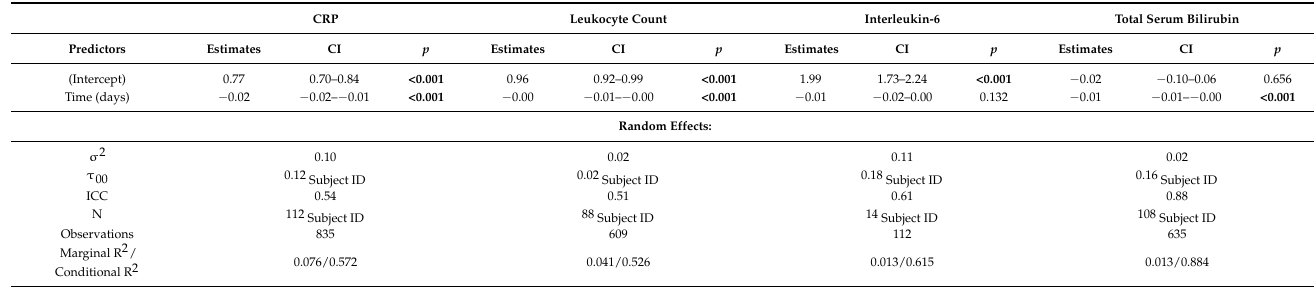
Table 4. Parameters of the generalized linear mixed models used in Figure 4.